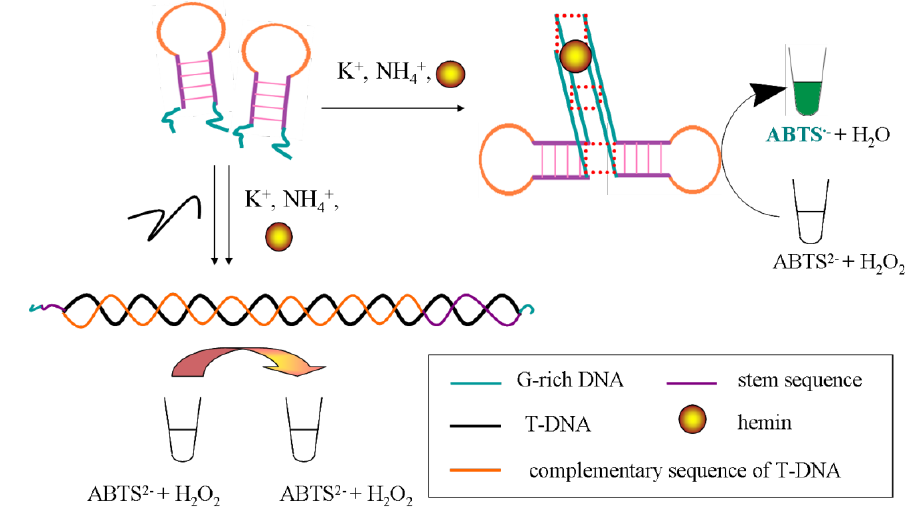
Figure 1. Working principle of the 1:1:1:1 split G-quadruplex DNAzyme MB sensor for PH nrDNA